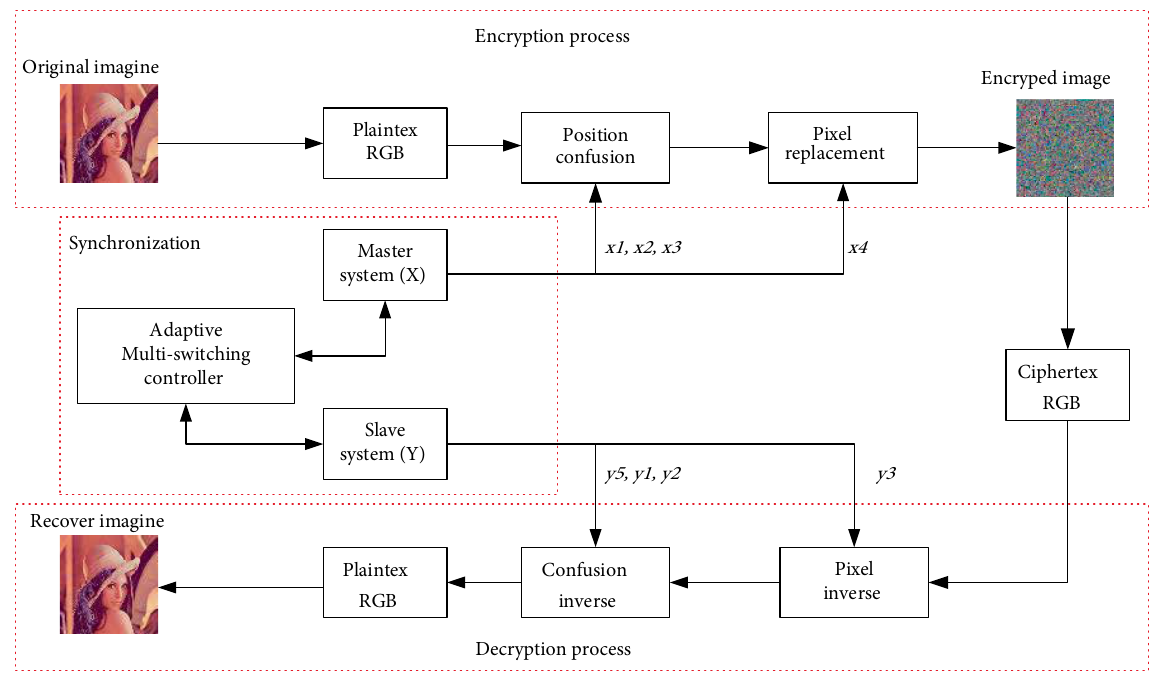
Figure 12: The overall structure of image encryption and decryption.